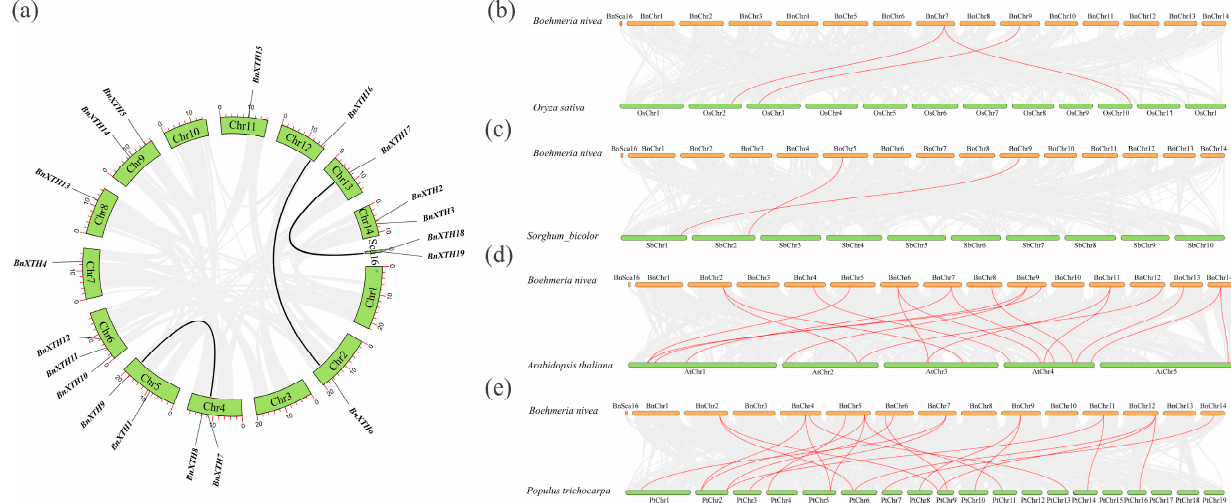
Figure 4. Chromosomal-level analyses of the BnXTH gene family in the ramie genome. ( a ) Synteny analysis of BnXTHs. The black lines indicate collinearity blocks and fragment-doubling events. ( b – e ) Synteny analysis of BnXTHs between Boehmeria nivea and Oryza sativa , Sorghum bicolor , Arabidopsis thaliana , and Populus trichocarpa .